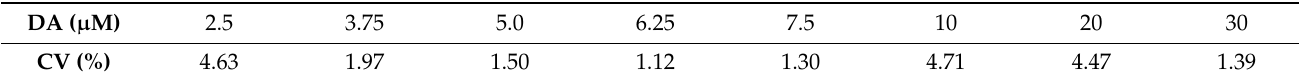
Table 2. The precision of aptasensors in different concentrations of DA ( n =